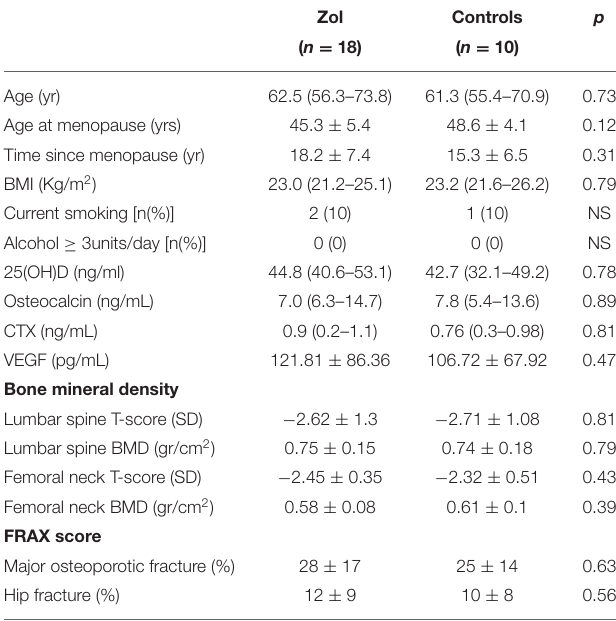
TABLE 1 | Main clinical features of recruited women at